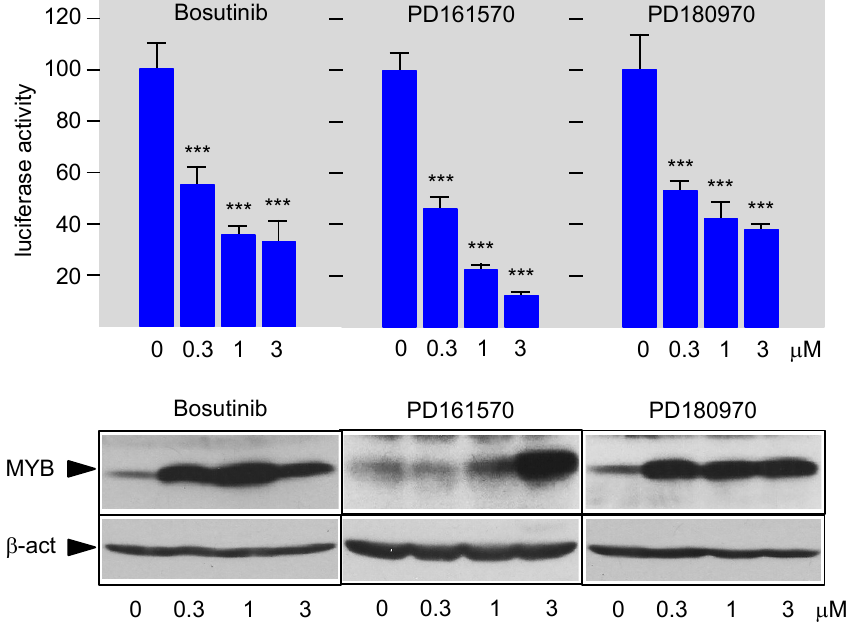
Figure 4. Bosutinib, PD161570, and PD180970 suppress the activity of the MYB transactivation domain. HEK293T cells transfected with an expression vector for a Gal4-CT3 fusion protein and the Gal4-responsive reporter gene pG5E4-38Luc were distributed in microtiter plates and treated for 16 h with the indicated compound concentrations. Luciferase activities are displayed as in Figure 2. The expression of Gal4 ‐ CT3 and β‐ actin is shown in the bottom panels. Asterisks indicate statistical significance (*** p < 0.001; Student’s t ‐ test).